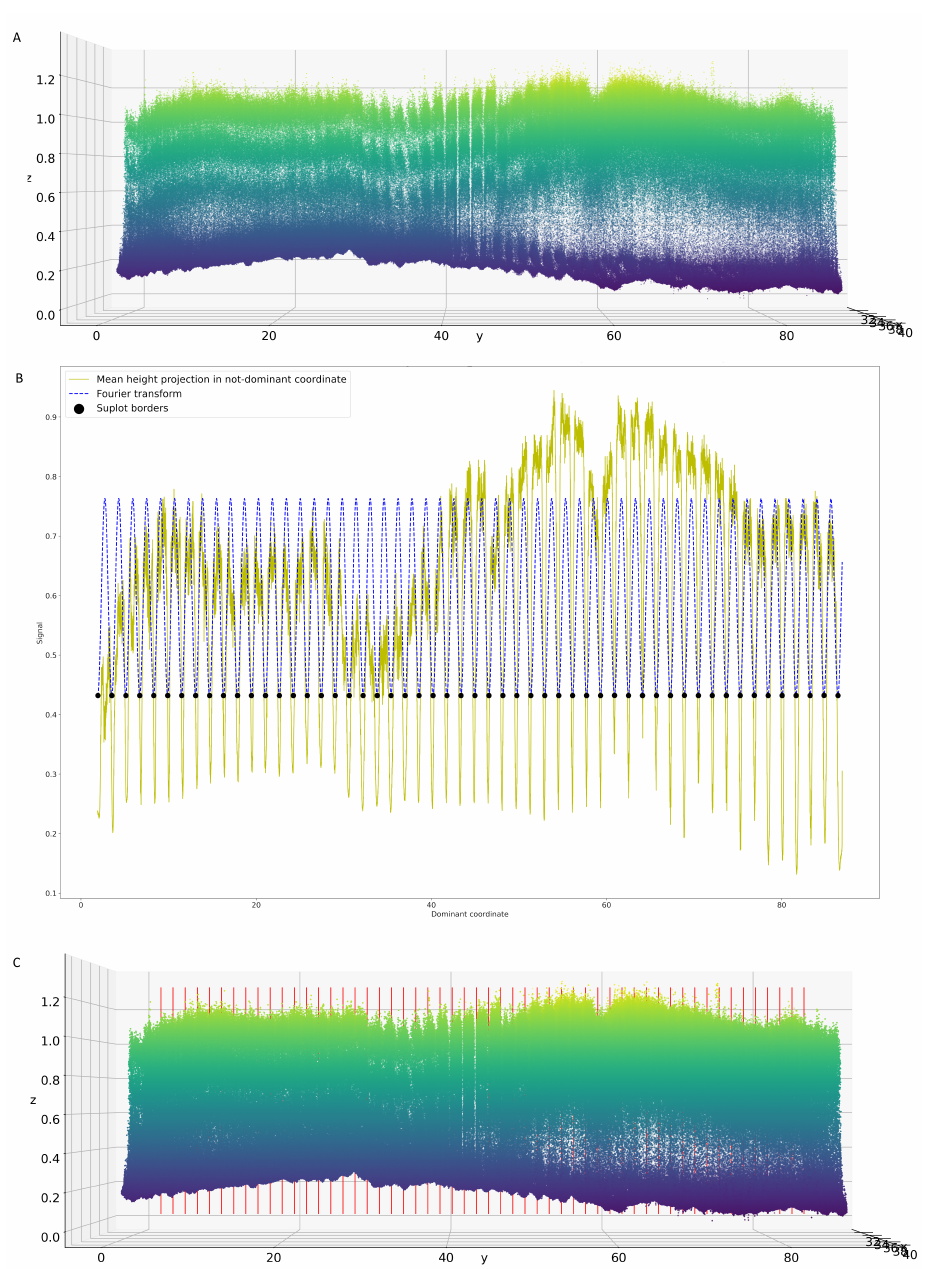
Figure 8. Detection of individual field plots using Fourier transformation. ( A ) Points of single experimental block (front view); ( B ) Plots border detection using Fourier t.; ( C ) Borderlines of individual block-plots depicted by the